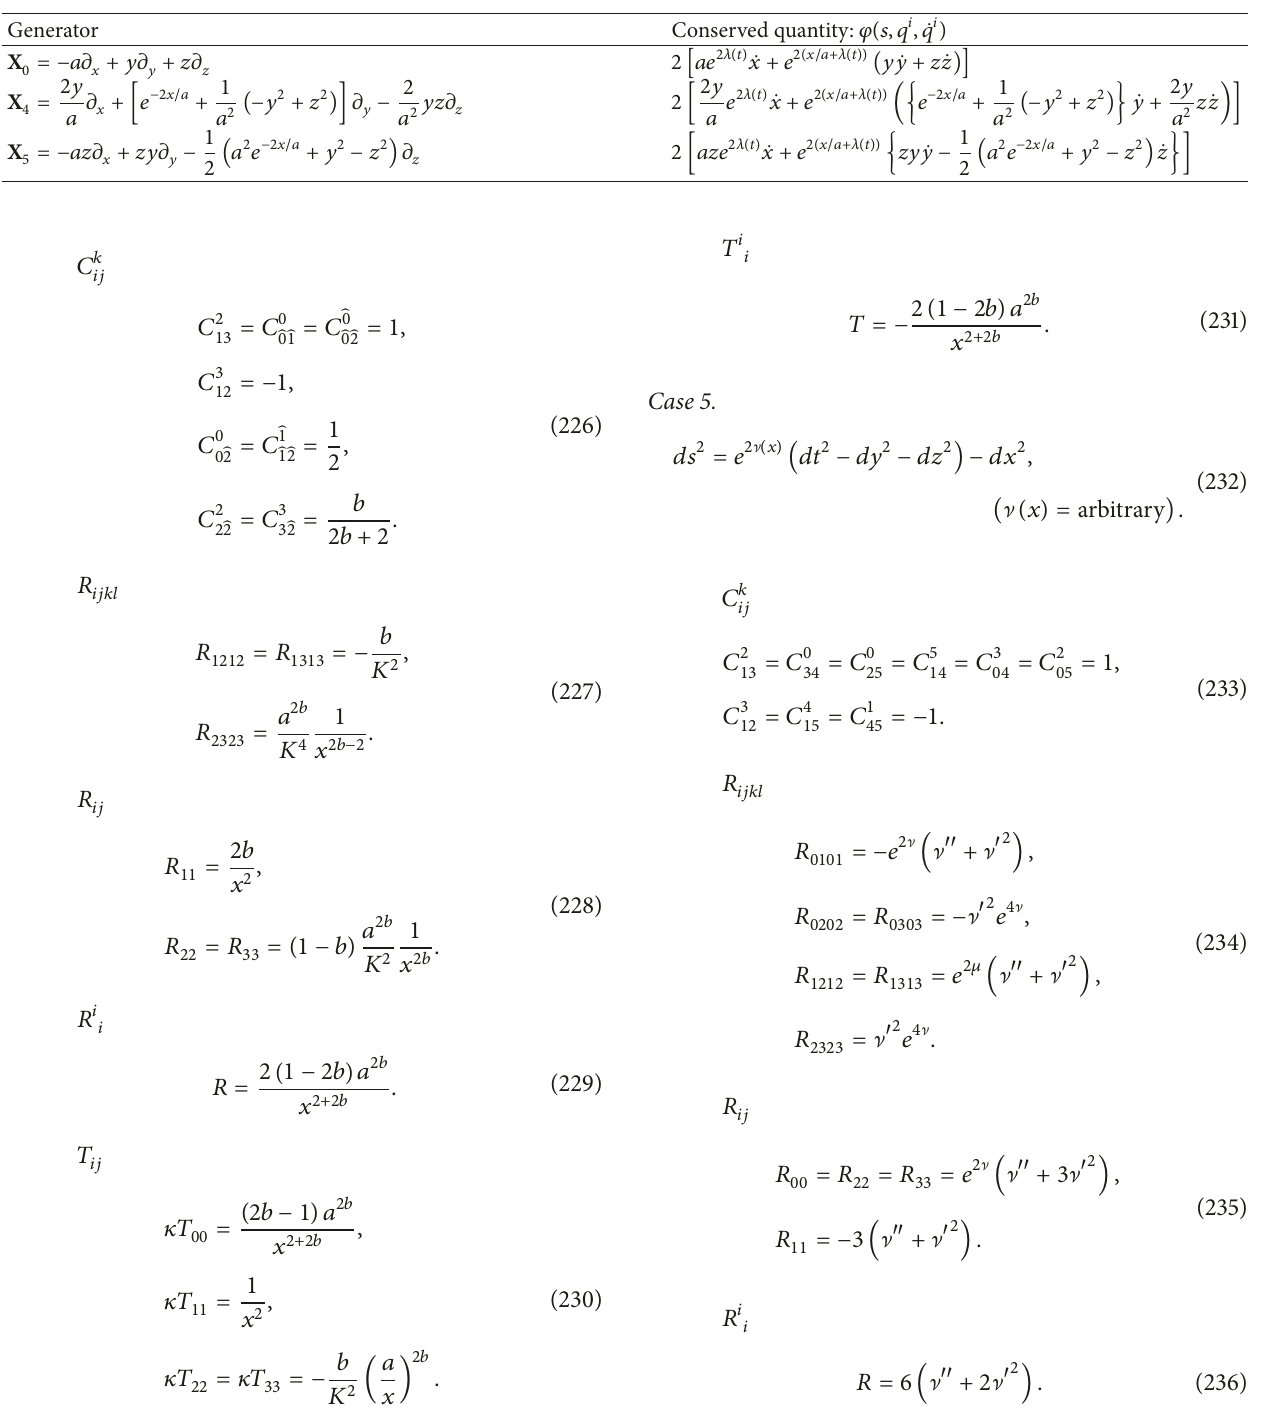
Table 36: Conserved quantities corresponding to each Noether